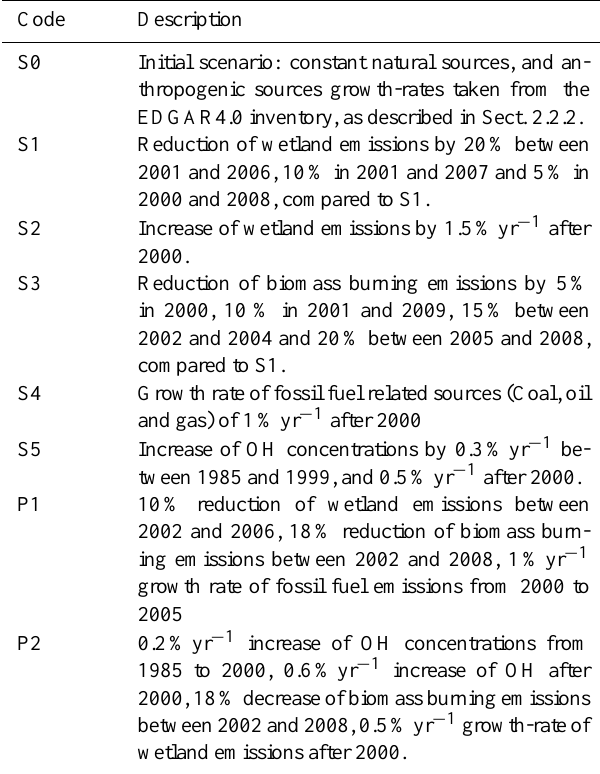
Table 2. Performed sensitivity